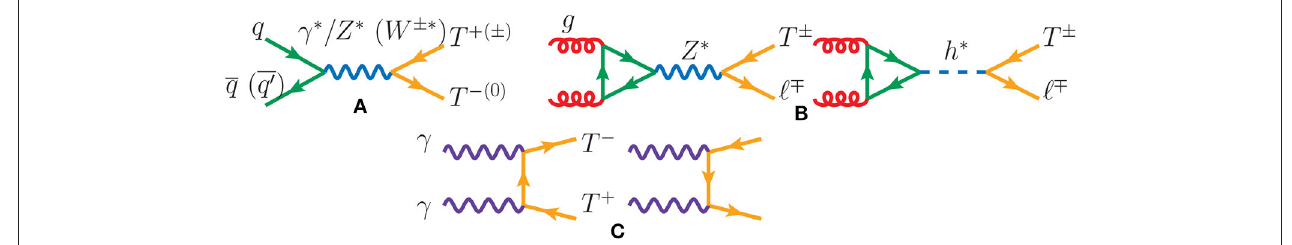
FIGURE 36 | (A) As a function of mass, the N ℓ ± (singlet) as well as T + T − and T ± T 0 (triplet) DY production cross sections at √ s of collider energy √ s , the T + T − and T ± ℓ ∓ (assuming benchmark